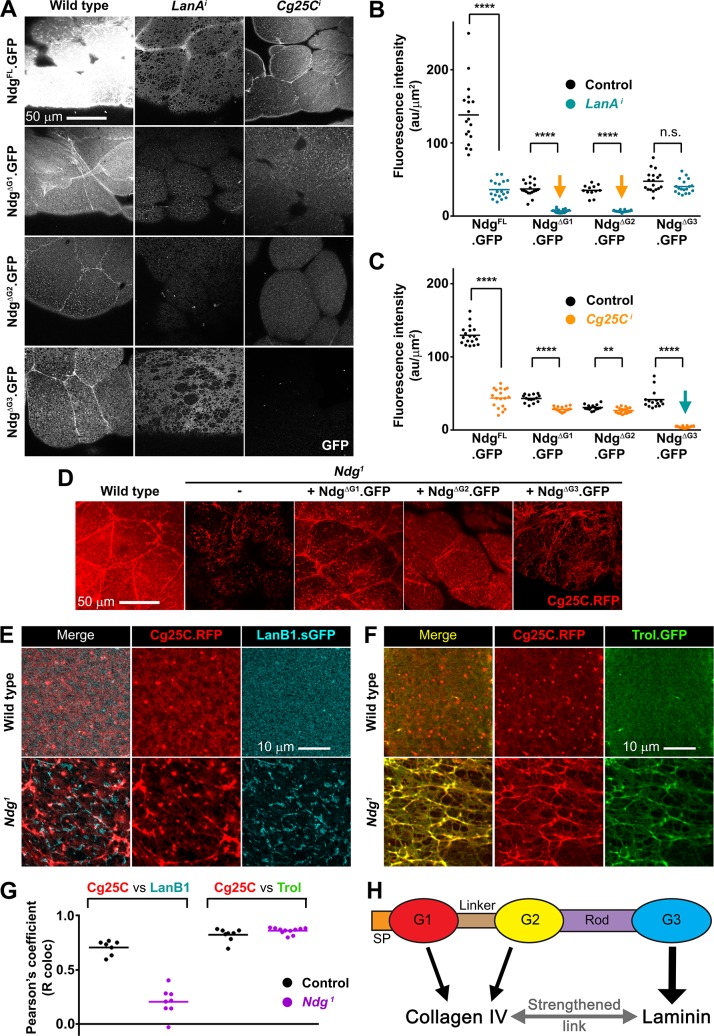
The G3 domain is essential for Ndg function.(A) Confocal images showing localization in fat body BM of the indicated GFP-tagged versions of Ndg, detected by GFP signal (white), in wild type (left column) and upon knock down of laminin (LanAi, middle column) and Collagen IV (Cg25Ci, right column). (B, C) Quantification of GFP signal intensity of indicated GFP-tagged Ndg versions in the BM of wild type control, LanAi (B) and Cg25Ci (C) fat body. Each dot represents a single measurement of intensity inside a 500μm2 square. Horizontal lines indicate the mean value (****: p<0.0001; **:p<0.01; n.s.: not significant). See Materials and Methods for statistical testing details. (D) Confocal images of the larvae fat body BM (Cg25C.RFP in red) in control, Ndg1 mutant, and Ndg1 mutant expressing NdgΔG1, NdgΔG2 or NdgΔG3. Integrity of the BM is restored by NdgΔG1 and NdgΔG2 but not NdgΔG3. (E) Confocal images showing uncoupling of Collagen IV (Cg25C.RFP in red, middle panels) and Laminin (LanB1.sGFP in cyan, right panels) in Ndg1 mutant (lower panels) and wild type fat body (upper panels). Merged channels are shown in left panels. (F) Confocal images of Collagen IV (Cg25C.RFP in red, middle panels) and Perlecan (Trol.GFP in green, right panels) in Ndg1 mutant (lower panels) and wild type fat body (upper panels). Merged channels are shown in left panels. (G) Quantification of Pearson’s colocalization coefficient after Costes thresholding (R coloc) of Collagen IV with Laminin (E) and Collagen IV with Perlecan (F). (H) Model for the role of the G1, G2 and G3 domains on Ndg binding to Laminin and Collagen IV.